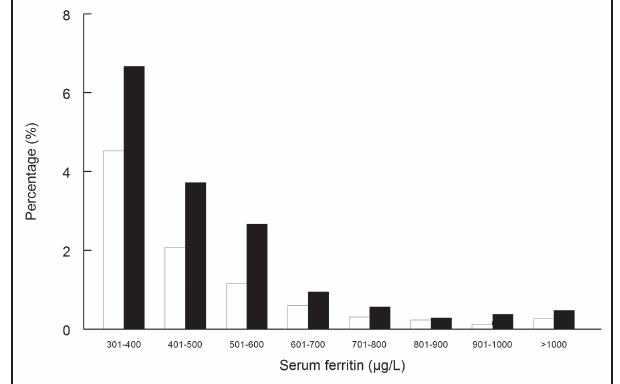
Figure 2) A comparison of the percentage of Hemochromatosis and Iron Overload Screening (HEIRS) study participants with an elevated serum ferritin level in H63D homozygotes (n=1049) (black bars) and participants without H63D or C282Y mutations (n=32,134) (open bars). All